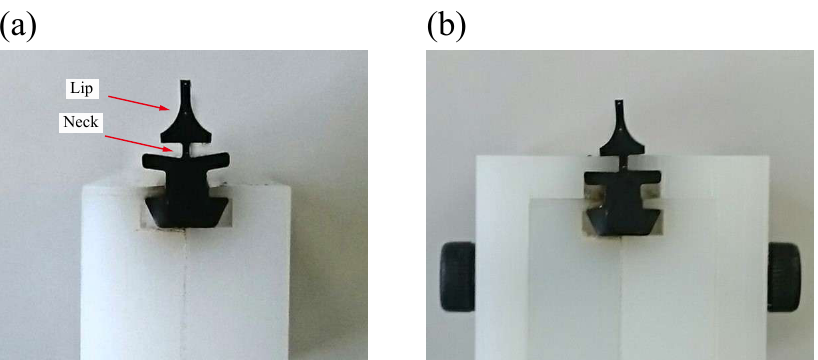
Figure A2. Two fixation methods of the experimental setup. ( a ) The neck can be rotated. ( b ) The neck is fixed.